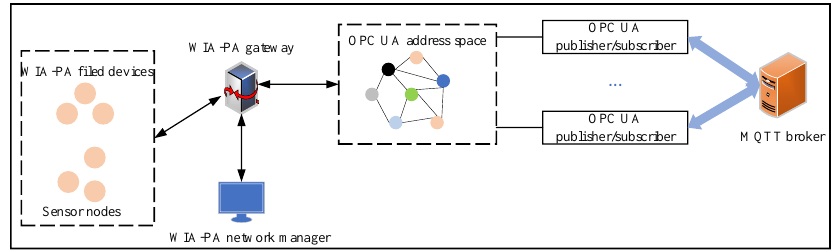
Figure 6. OPC UA pub/sub communication architecture for WIA-PA.